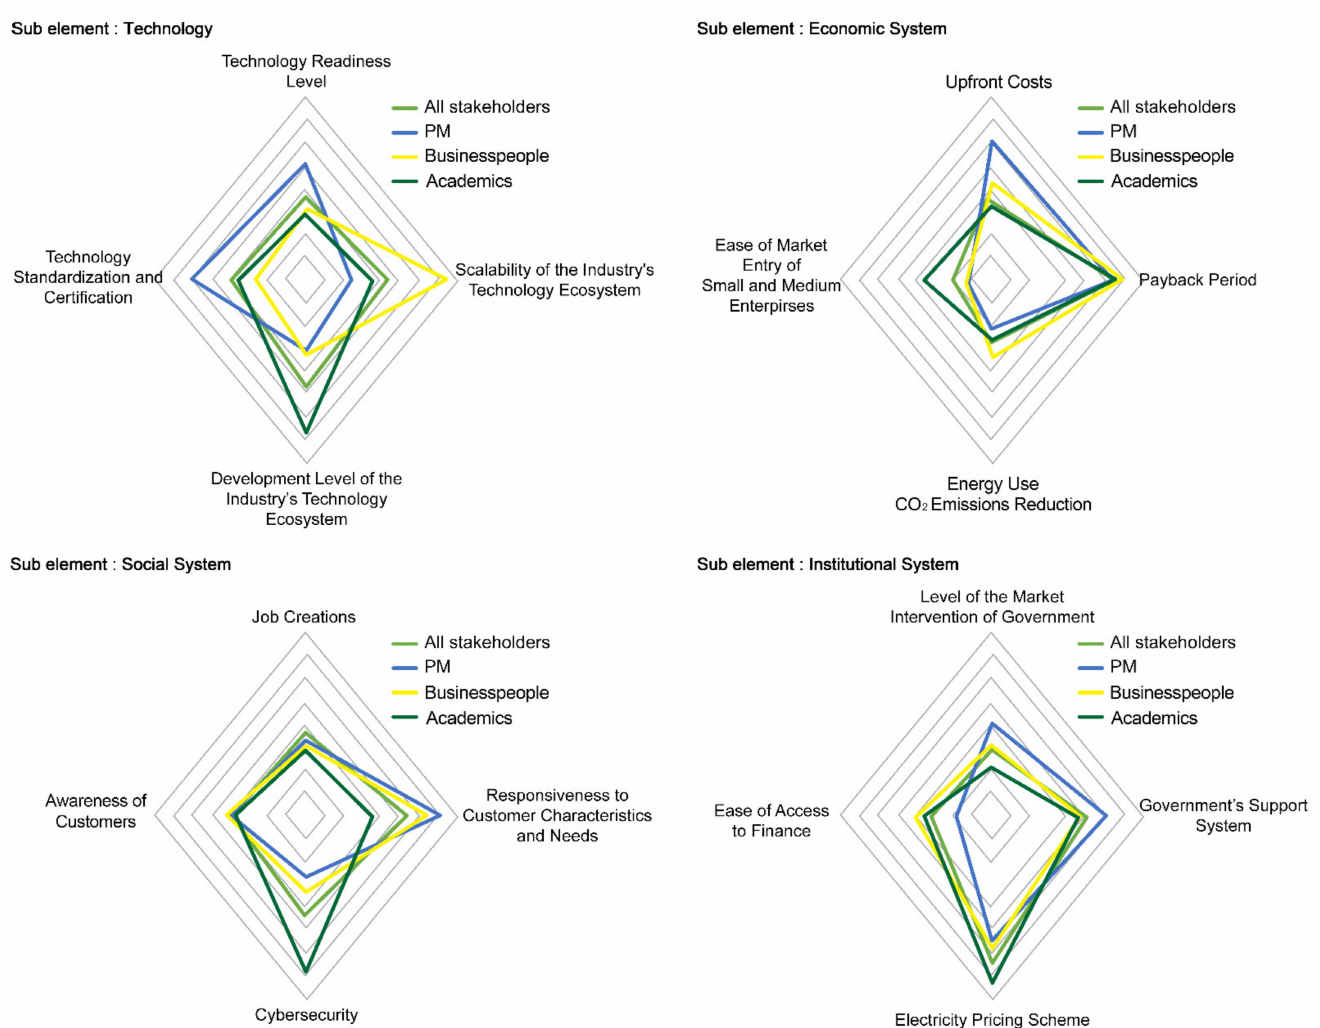
Figure 4. Consistency of the sub-element evaluation results among